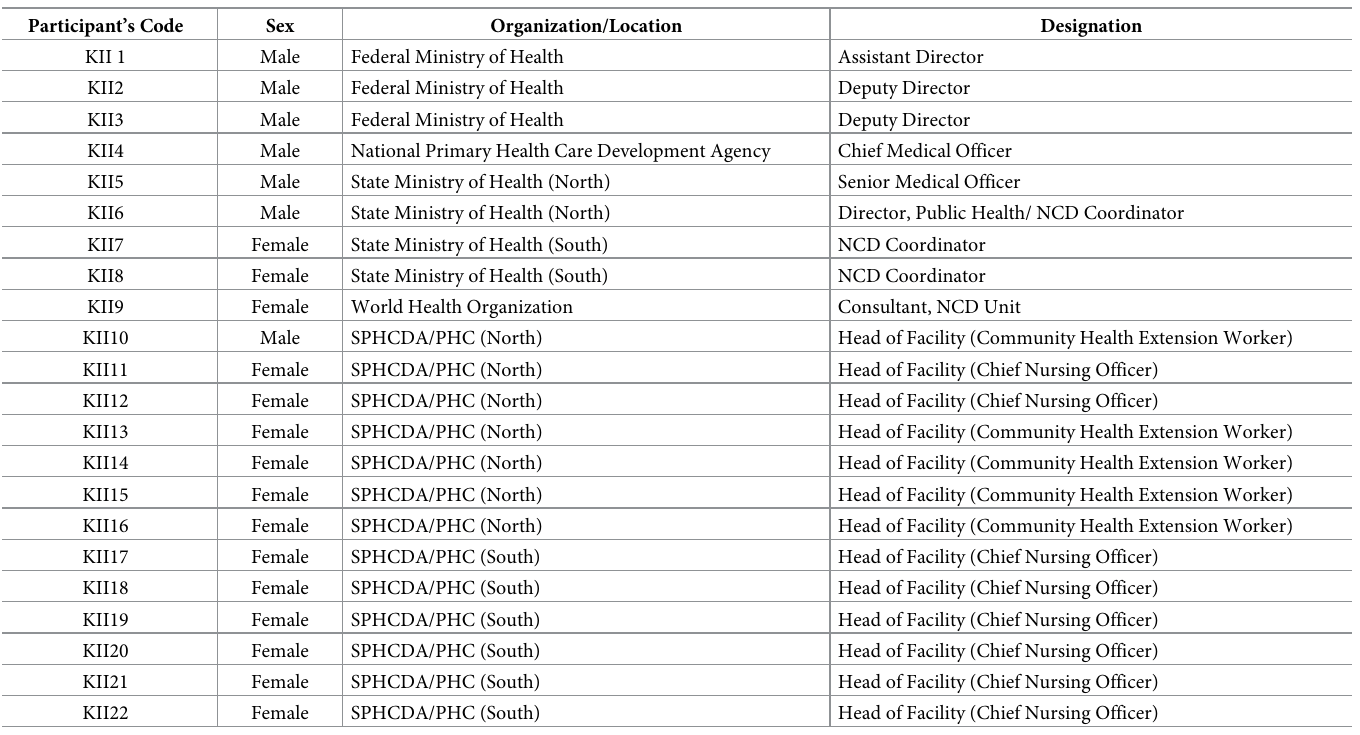
Table 1. Participants of key informant interview